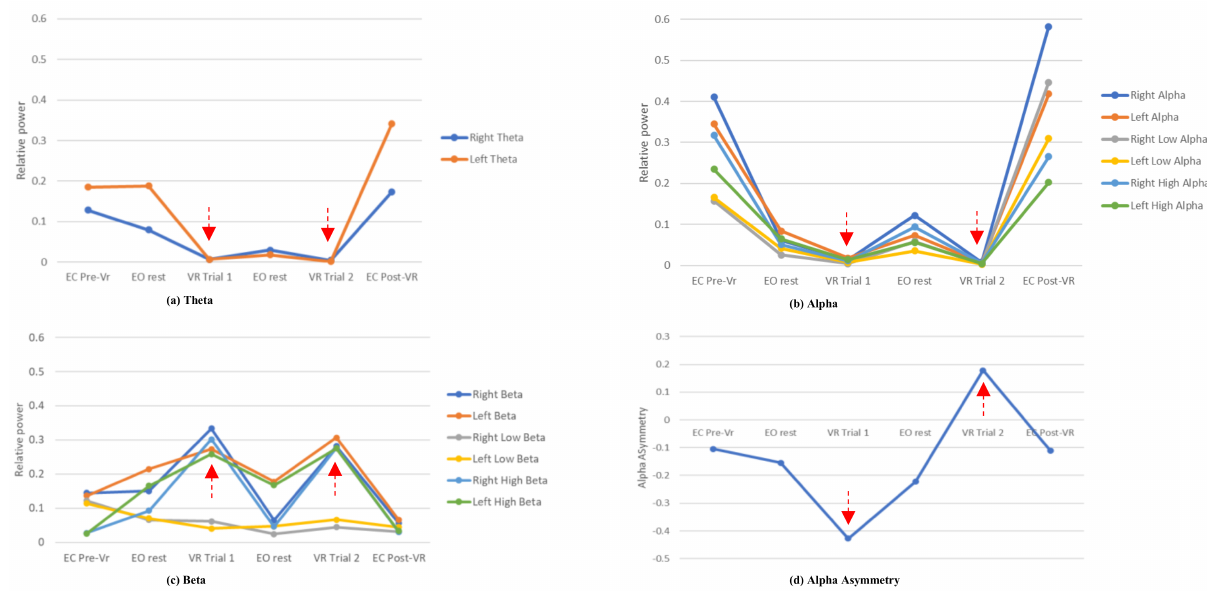
Figure 12. Changes of ( a ) theta, ( b ) alpha and ( c ) beta relative powers, and ( d ) alpha asymmetry throughout the six